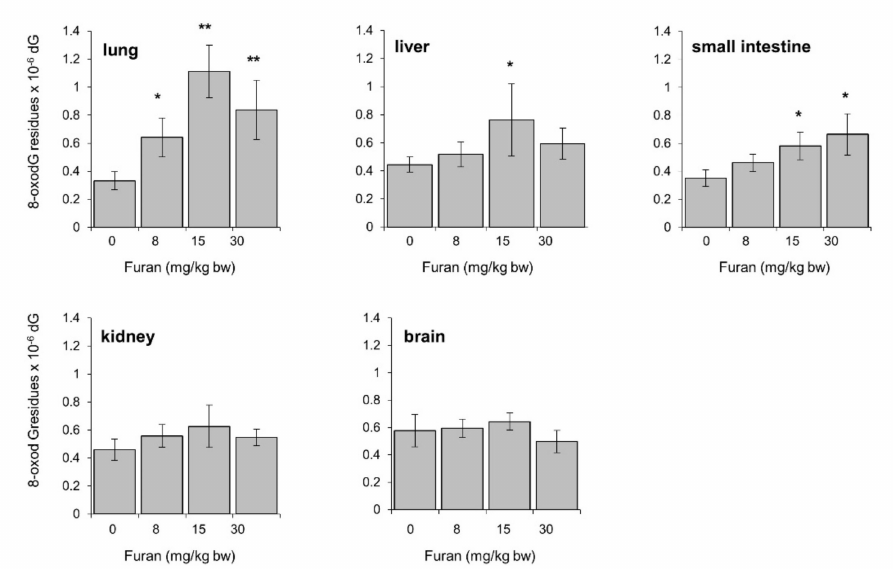
Figure 7. Levels of 8-oxodG in lung, liver, small intestine, kidney, brain DNA in C57Bl6 mice following a 28-day oral exposure to increasing furan concentrations. The amount of 8-oxodG residues/10 6 dG was measured in genomic DNA by HPLC/EC (see Section 4). All values are mean +/ − SE (5–11 animals/group). Asterisks indicate significant differences (* p < 0.05; ** p < 0.01 by two-tailed Student’s t -test).